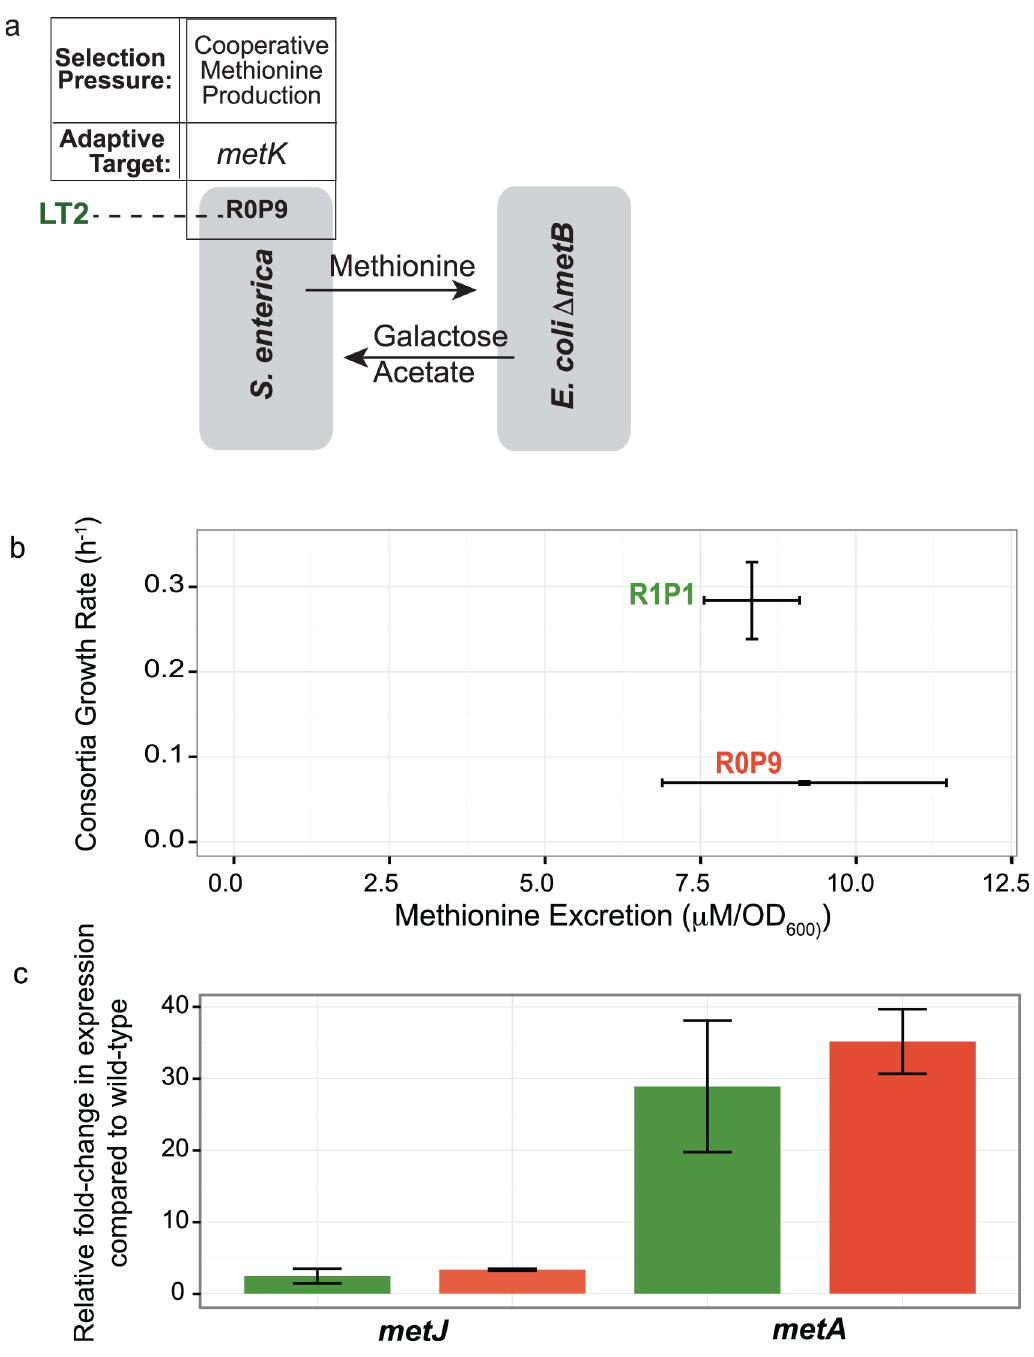
Fig 1. R0P9 evolved cooperation without first selecting for transcriptional deregulation. a) R0P9 was evolved directly from wild-type S . enterica LT2 co-culturedwith an E . coli methionine auxotrophon lactose minimalmedia. Sequencingrevealed the causative mutation in metK , which resulted in methionine productionand excretionenabled growth of E . coli Δ metB , which in turn excretes usable carbon for S . enterica . b) ProducerR0P9, evolved without first selectingfor ethionineresistance, excretes similar amounts of methionine comparedto R1P1, evolved from ethionine resistancebackground. Yet R0P9, when co-cultured with E . coli Δ metB in lactose minimalmedia, contributes to a much slower consortia growth comparedto R1P1. c) R1P1 and R0P9 express similarlyincreasedlevels of metJ and metA comparedto LT2 wild-typeancestor. Error bars indicate standarderror of three biological replicates.